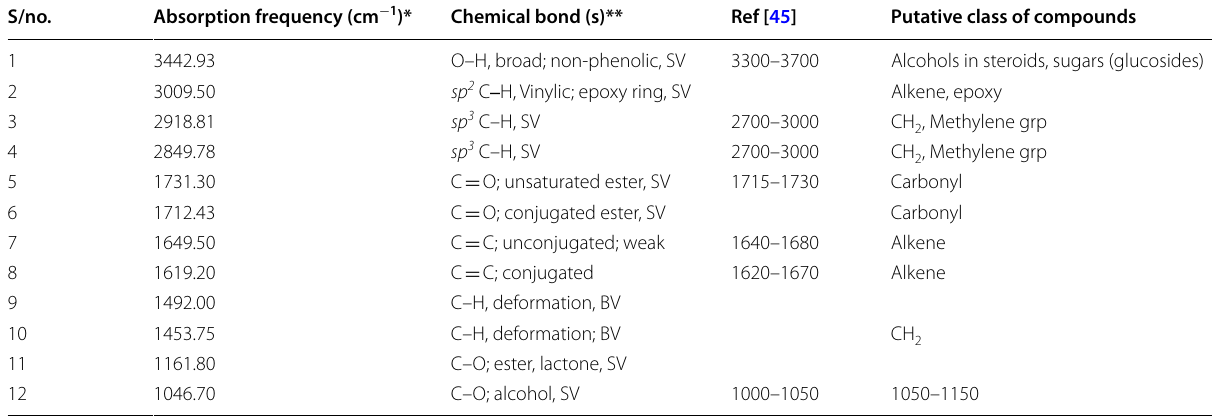
SV strong vibration; BV bending vibration